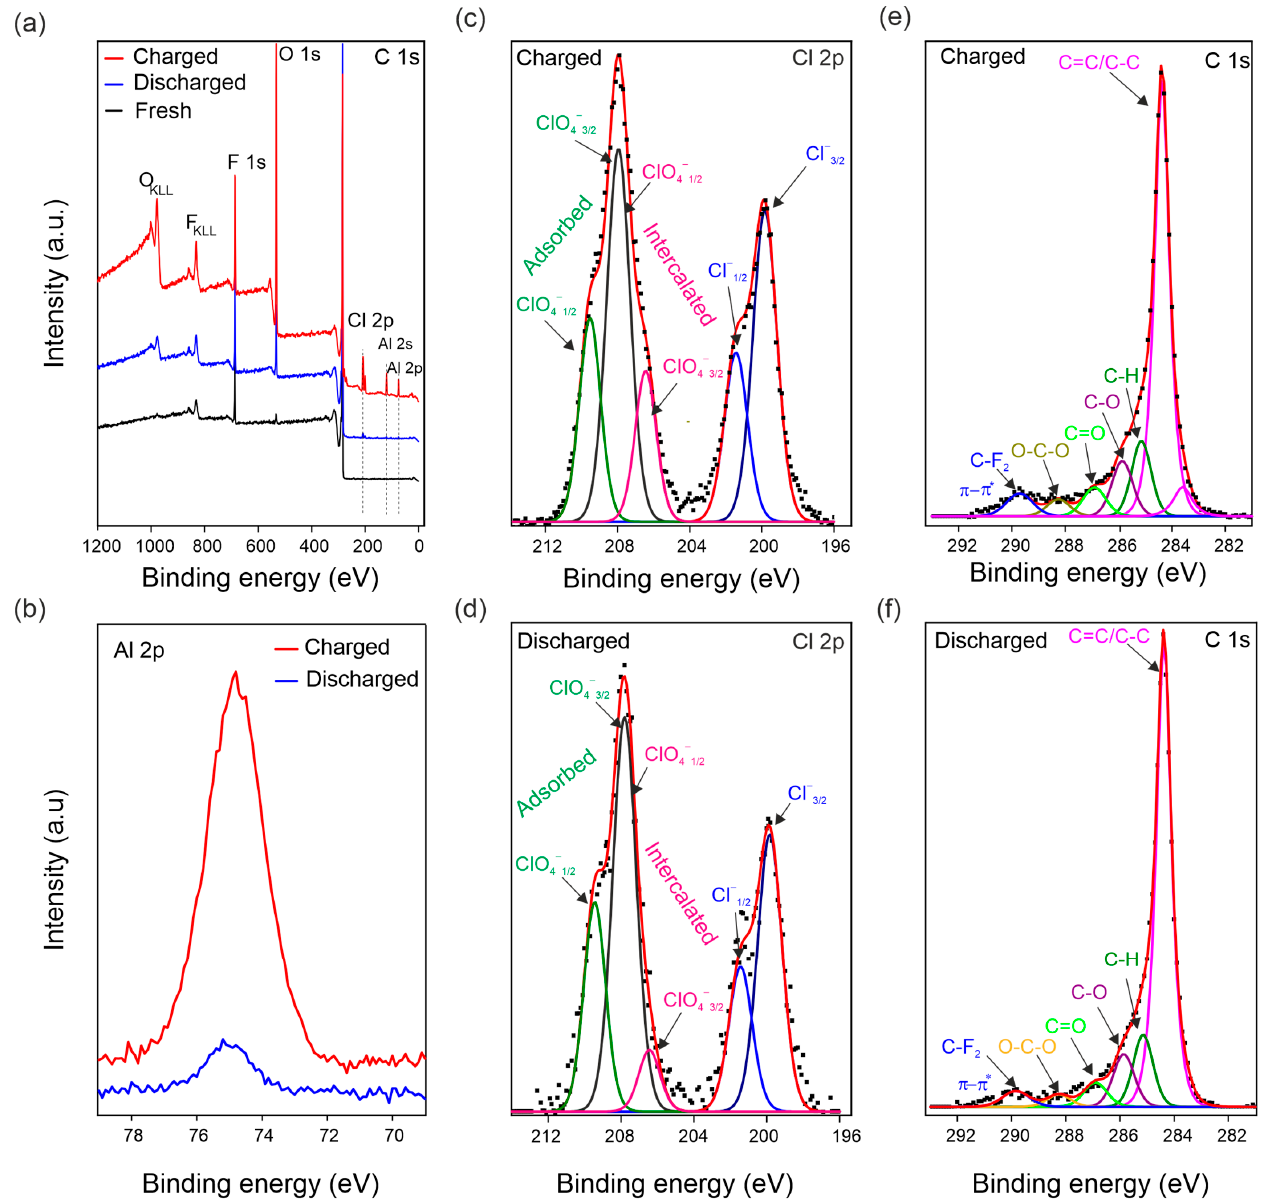
Figure 5. Ex situ XPS analysis of US-NG in fresh, charged, and discharged states using 2.4 M Al(ClO 4 ) 3 aqueous electrolyte solution. ( a ) Survey XPS spectrum; ( b ) high-resolution XPS spectra of the Al 2p core levels in the charged and discharged states; deconvoluted high-resolution XPS spectra of the Cl 2p core levels in the charged ( c ) and discharged states ( d ) (note, the Cl 2p 1/2 of intercalated ClO 4 − and Cl 2p 3/2 of adsorbed ClO 4 − overlap at 208.0 eV); deconvoluted high-resolution XPS spectra of the C 1s core levels in the charged ( e ) and discharged states ( f